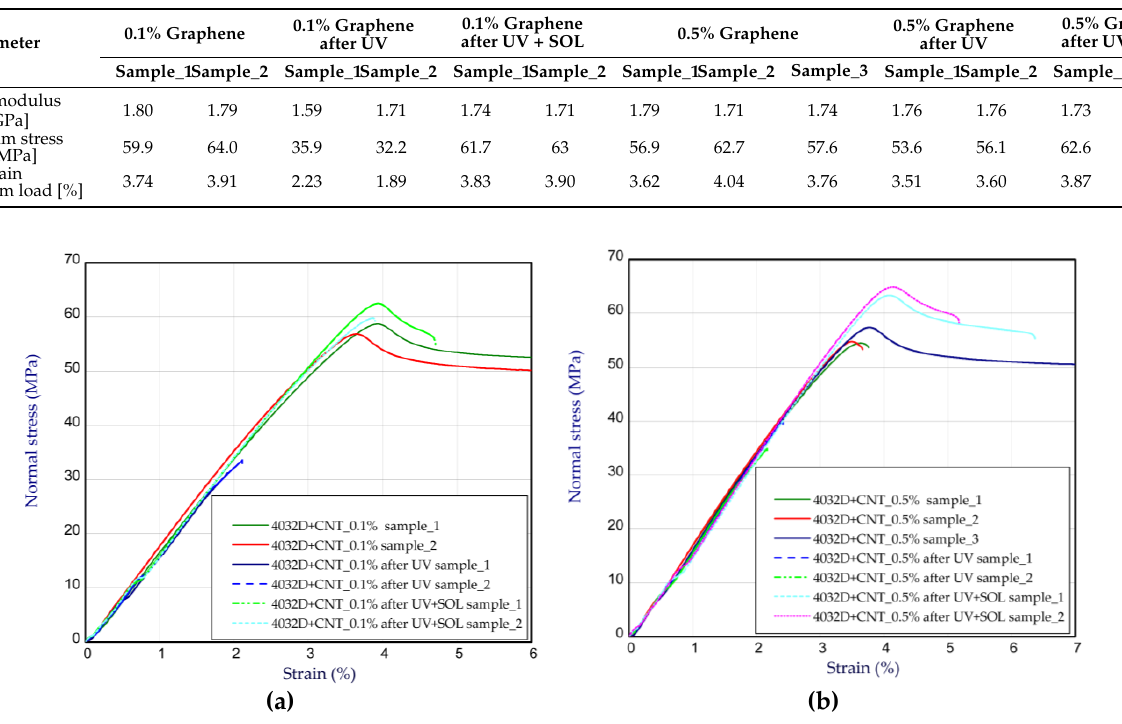
Figure 10. The curves of tensile tests for samples 4032D admixed with CNTs at 0.1 wt.% ( a ) and 0.5 wt.% ( b ). Table 1. Characteristic parameters obtained in tensile tests for samples 3001D, 4032D and 4043D.